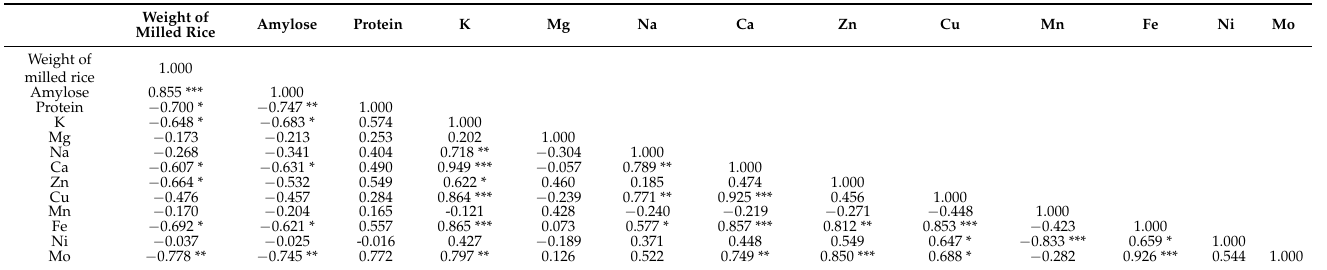
Table 5. Correlation between grain quality and